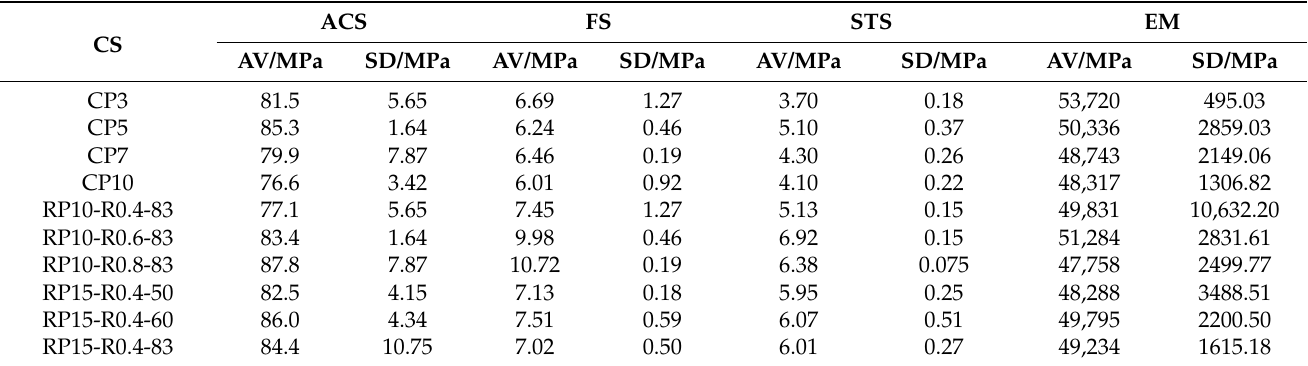
Table 14. Average value and standard difference of mechanical characteristics of concrete and steel fiber